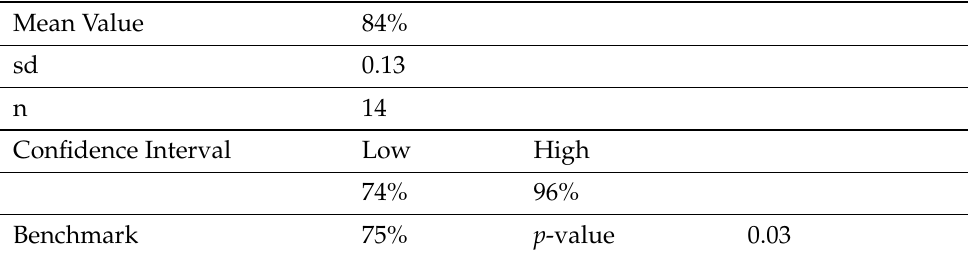
Table 14. Statistics Per Efficiency of cobot in